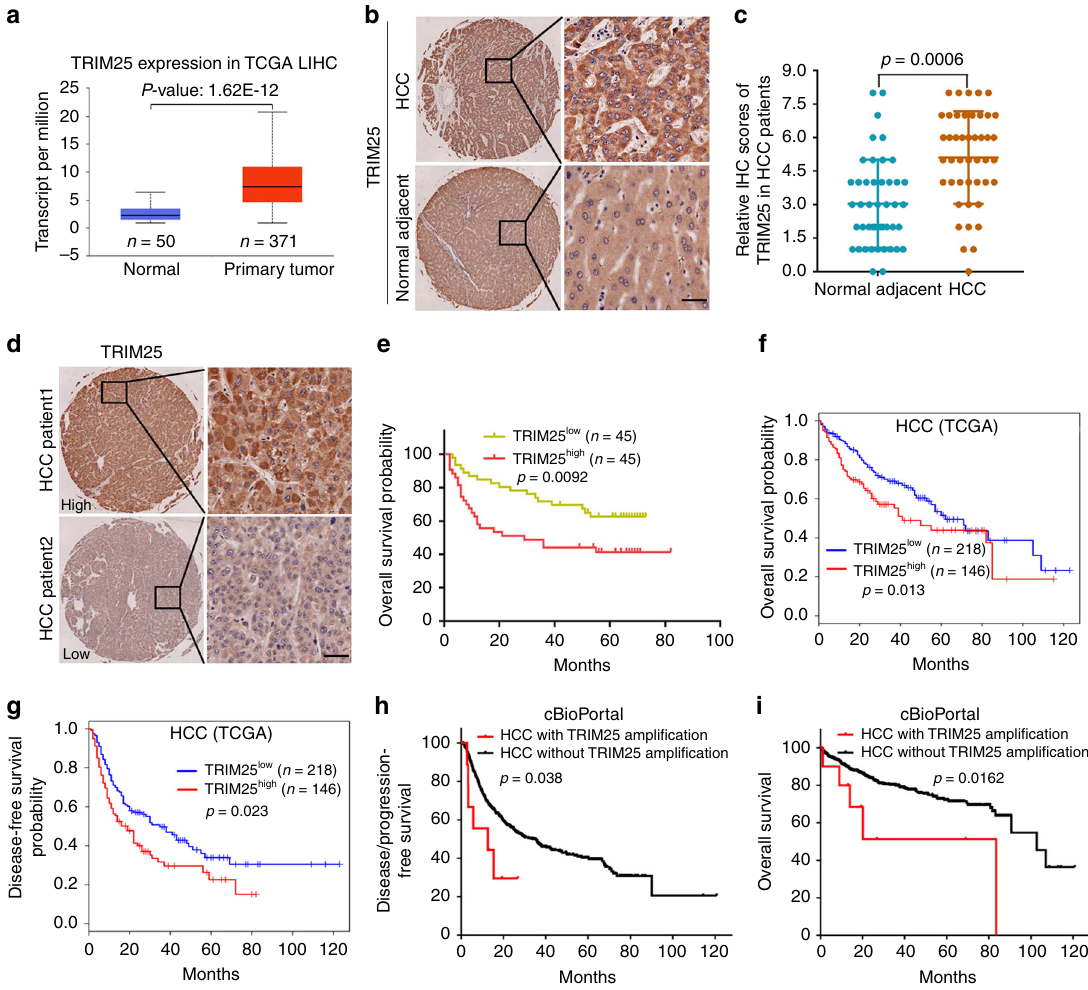
Fig. 7 Upregulation of TRIM25 in HCC correlates with poor prognosis. a Comparison of the TRIM25 mRNA level between HCC and normal tissues in TCGA database. Normal tissues/ Primary tumor tissues: n = 50/371, maximum = 6.396/20.772, upper quartile = 3.461/10.888, median = 2.299/7.382, lower quartile = 1.608/4.781, minimum = 0.925/0.936. Statistical signi fi cance was assessed using two-tailed Student ’ s t-test. b , c Representative images ( b ) of IHC staining and the relative IHC scores ( c ) of TRIM25 in HCC tissues and adjacent normal tissues. Scale bar, 50 μ m. Data represent the mean ± SEM (adjacent normal tissues, n = 45; HCC tissues, n = 45). The IHC score ranging from 0 to 8 was calculated by multiplying the staining extent score with the staining intensity score. Statistical signi fi cance was assessed using two-tailed Student ’ s t-tests. d , e Representative images of IHC ( d ) and Kaplan – Meier analysis of overall survival probability ( e ) of TRIM25 levels in HCC patients. Scale bar, 50 μ m. The statistical signi fi cance was assessed using two-sided log-rank test according to HCC patients with low or high expression of TRIM25(TRIM25 low expression patients, n = 45; TRIM25 high expression patients, n = 45). f , g The overall survival ( f ) and disease-free survival probability ( g ) were compared between TRIM25 High ( n = 146) and Low expression ( n = 218) in HCC patients from TCGA cohort. h , i Disease/progression-free survival ( h ) and overall survival ( i ) were compared between HCC with TRIM25 ampli fi cation ( n = 11) and without TRIM25 ampli fi cation ( n = 594) in HCC patients from cBioPortal database. For e , f , g , h and i , the statistical signi fi cance was assessed using two-sided log-rank test, log-rank p values were